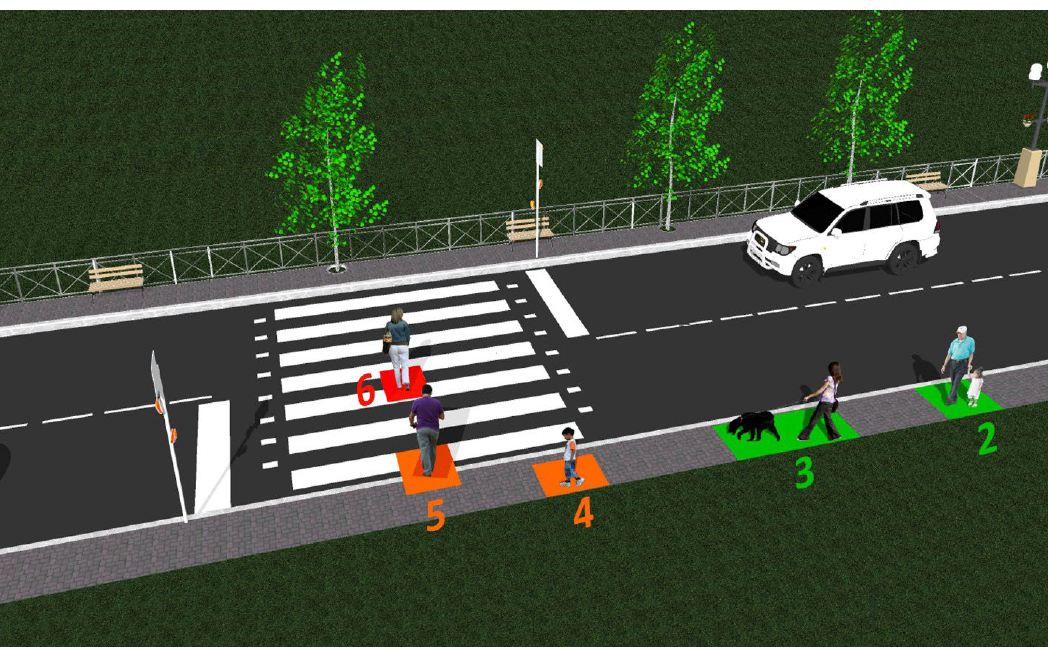
Figure 4. Illustration of the areas associated with the six alert levels. The color of the region indicates the danger level associated with each zone: green—low danger zone, orange—medium danger zone, red—high danger zone.